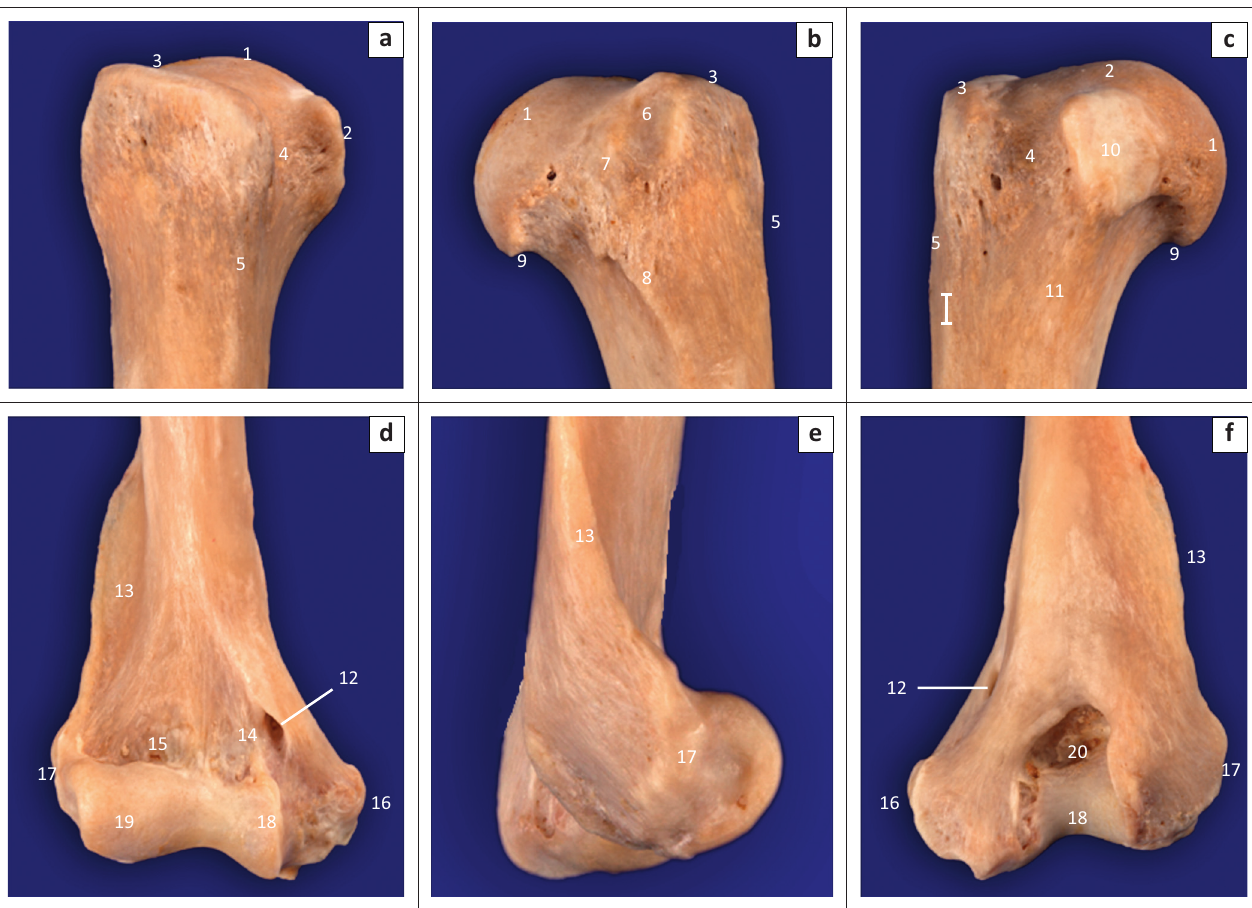
FIGURE 4: Bone specimen of (a–c) the right proximal and (d–f) the distal humerus of an adult red panda. Cranial views are shown in (a) and (d). Lateral views are shown in (b) and (e). Medial and caudal views are shown in (c) and (f), respectively.